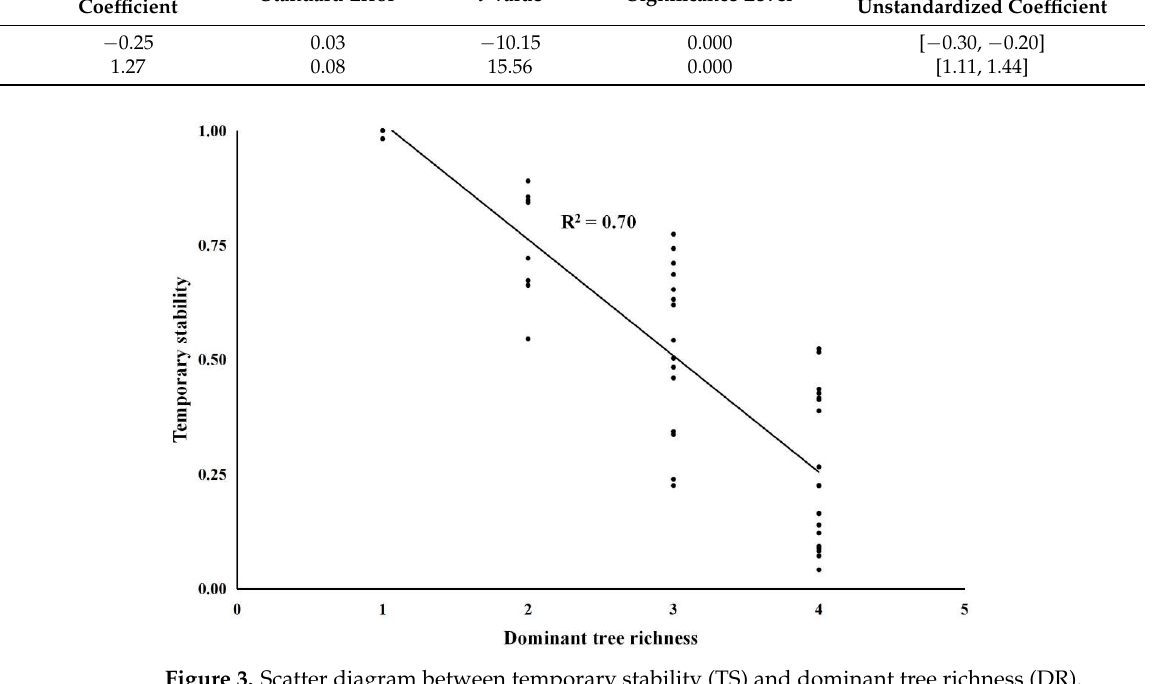
Figure 3. Scatter diagram between temporary stability (TS) and dominant tree richness (DR).